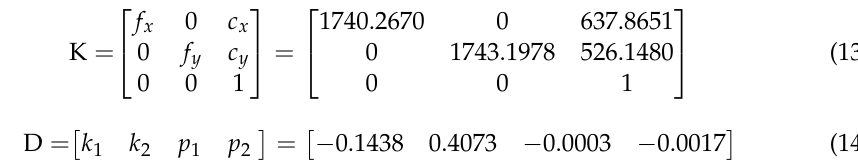
Figure 5. Mean reprojection error of nine images.